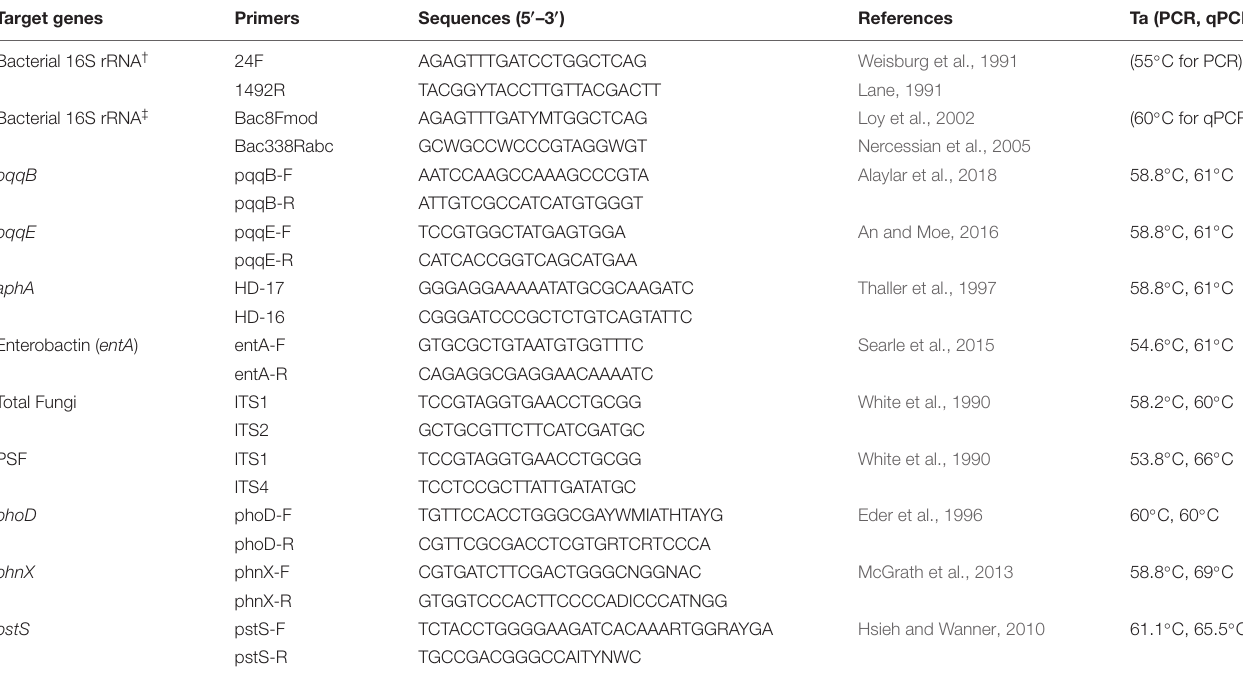
TABLE 1 | Genes, sequences of primers and annealing temperatures during PCR and qPCR. Target